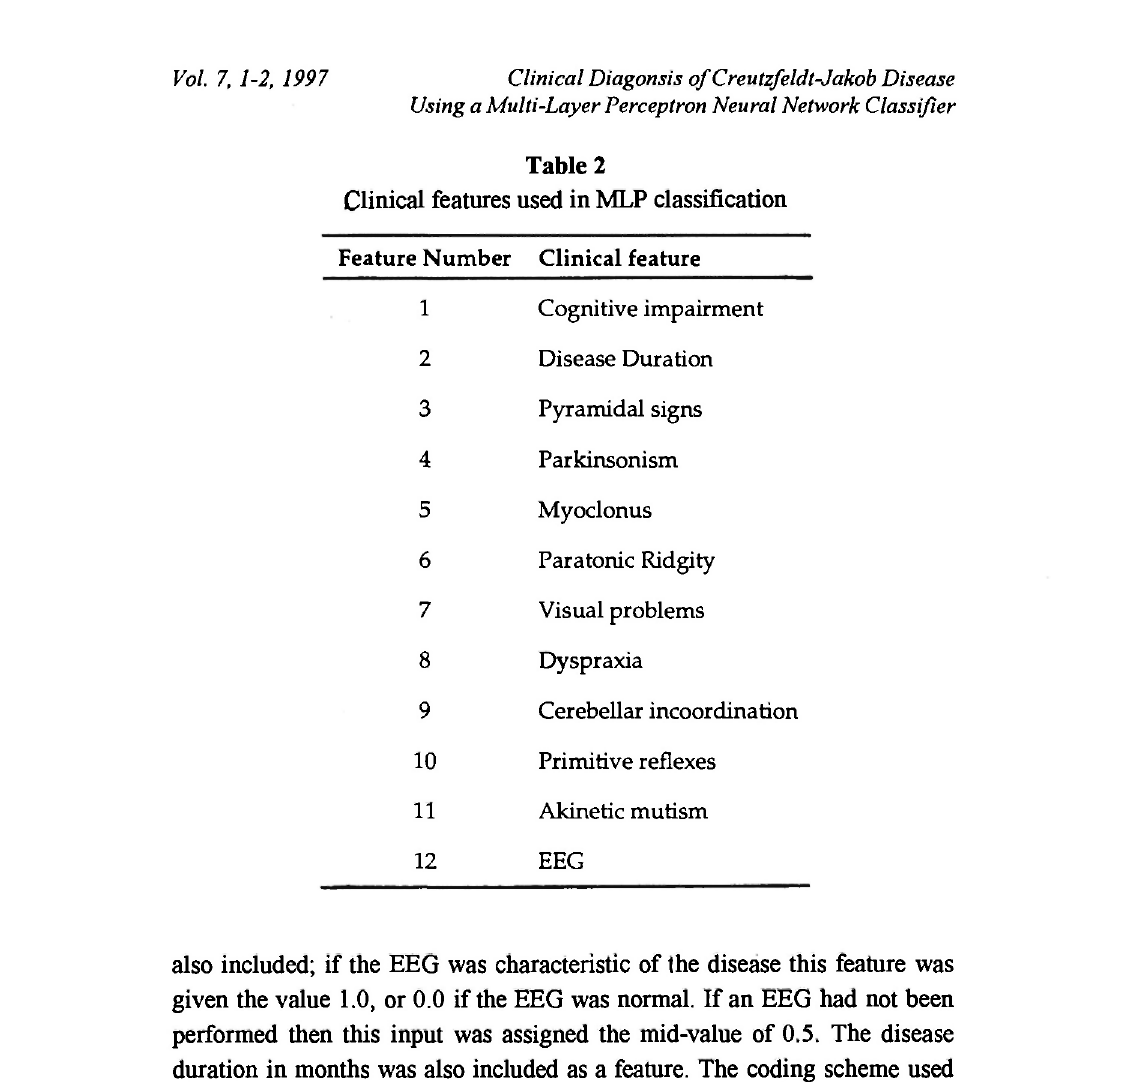
Clinical features used in MLP